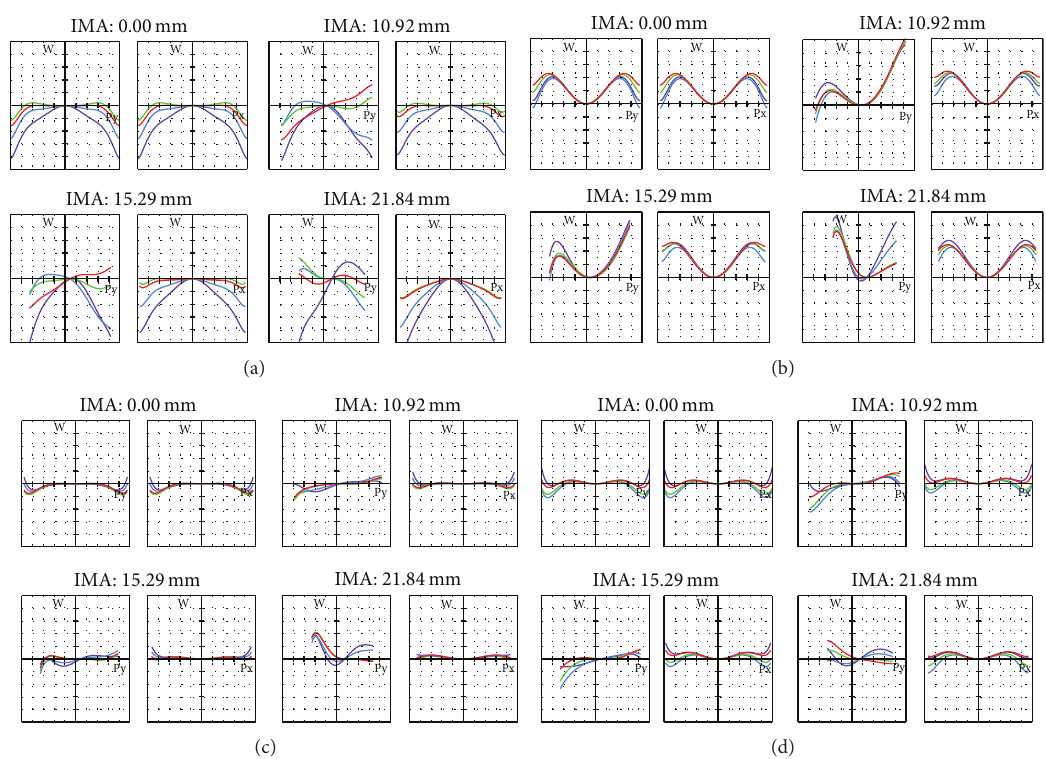
Figure 6: OPD fans for infinite object distance: (a) patent data, (b) iteration 1, (c) iteration 2, and (d) iteration 3. Plot scale is 2 waves.